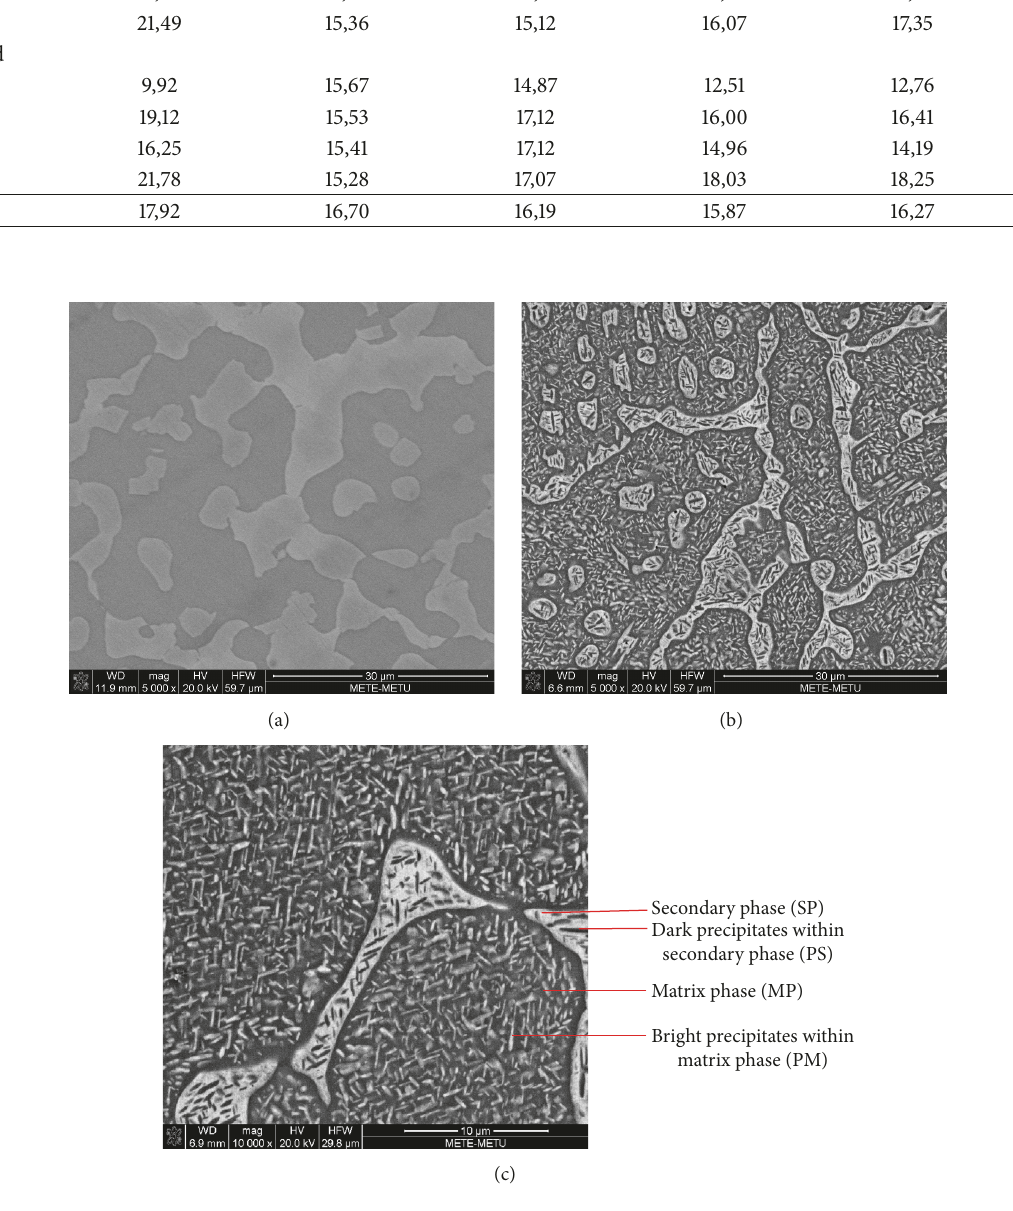
Figure 3: Backscattered SEM images of the (a) as-cast and (b) heat-treated sample. (c) A closer look to the heat-treated